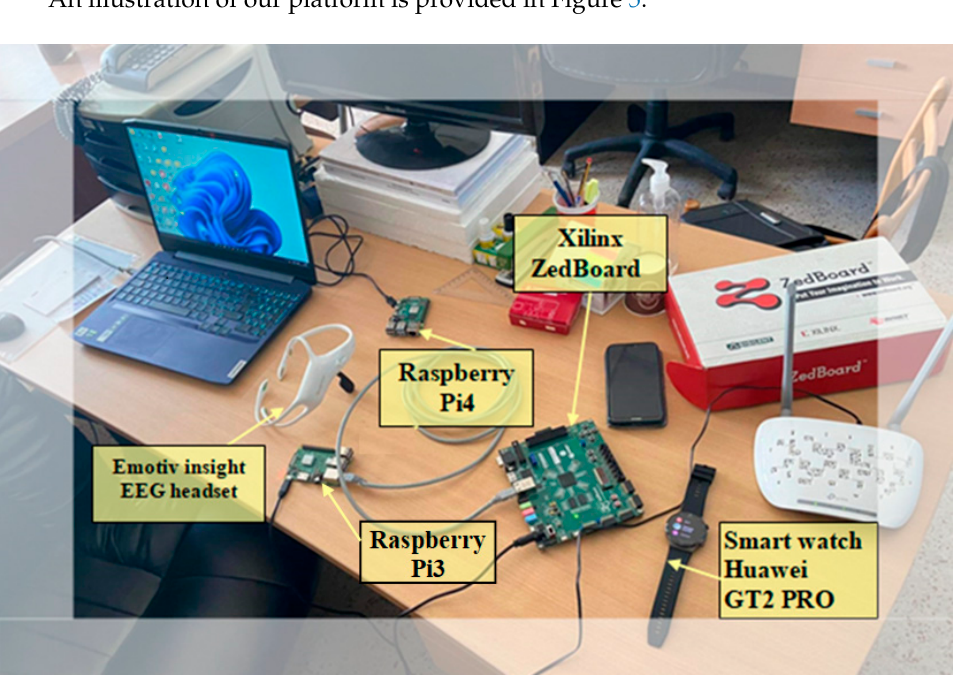
Figure 5. IoMT platform.